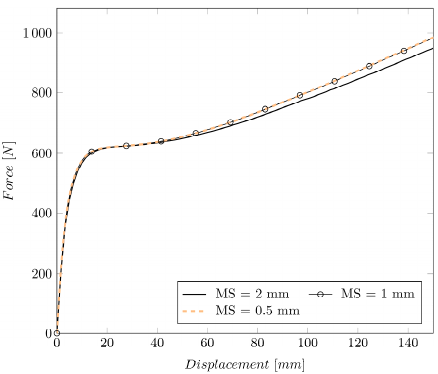
Figure A1. Comparison of the force–displacement curves of uniaxial tensile tests at 100 °C for a mesh size of 0.5 mm, 1 mm, and 2 mm.